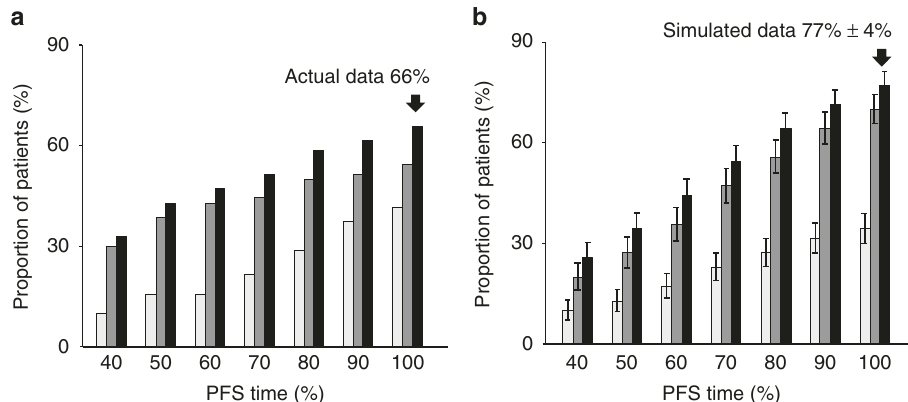
Fig. 5 Predicting disease progression using plasma CK18 and Tie2 levels. The fi gure shows the potential of Tie2, cytokeratin 18 (CK18), and both biomarkers modeled together to predict disease progression. The prediction made by CK18 alone is shown in light gray, by Tie2 alone is shown in mid-gray and using the combination of CK18 and Tie2 in black. a Shows predictions based on actual data where the combined biomarkers predicted progression in 66% of patients, whereas single biomarker predictions of progressive disease were achieved in 54 and 41%. Interestingly the prediction derived from CK18 occurred later than that from Tie2 with a lead-time of 50 days (14% PFS) as the increase in the Tie2 biomarker predates that of CK18. b Shows the same calculation but using simulations to fi ll any missing data. Again a signi fi cant improvement on the number of predictions was observed when Tie2 and CK18 were used jointly for prediction ( p < 0.0001, Mann – Whitney U compared with either single antigen), revealing clear evidence of additivity between the two biomarkers with respect to predicting progressive disease. Error bars indicate the standard error. CK18; cytokeratin 18, PFS; progression-free